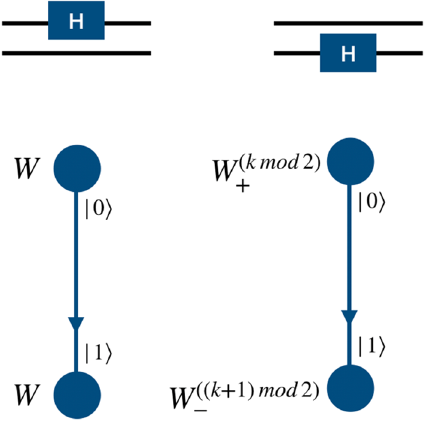
Figure 4. Schematic illustration of Hadamard operation on the computational basis of a two-qubit system using the W operator (Eq. (6)) on a single particle quantum walk on two-point position space. On the first qubit it is the Hadamard operation and on the second qubit Hadamard operation is realized using the σ x and I operators.